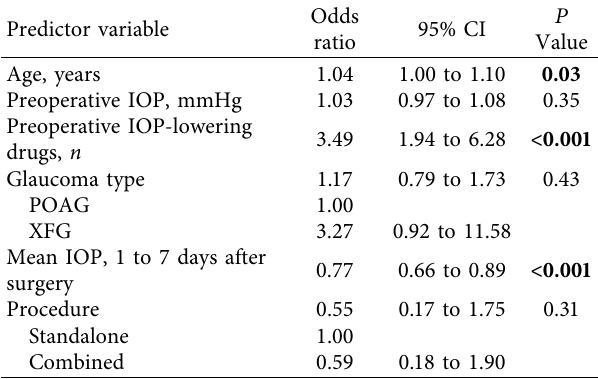
Table 2: Univariate analysis results (factors associated with the occurrence of choroidal detachment after Xen gel stent